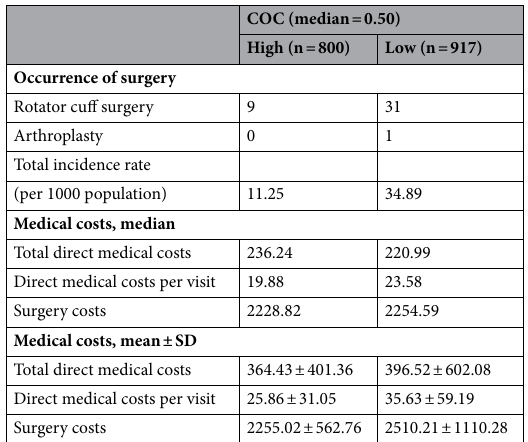
Table 2. Types of surgery and medical costs by COC. The occurrence of surgery is presented with numbers and incidence per 1000 population. Surgery costs are calculated only for patients who underwent shoulder surgery (n = 41). The medical costs are calculated in United States dollars in 31th June 2017 (1 USD = 1145 KRW).